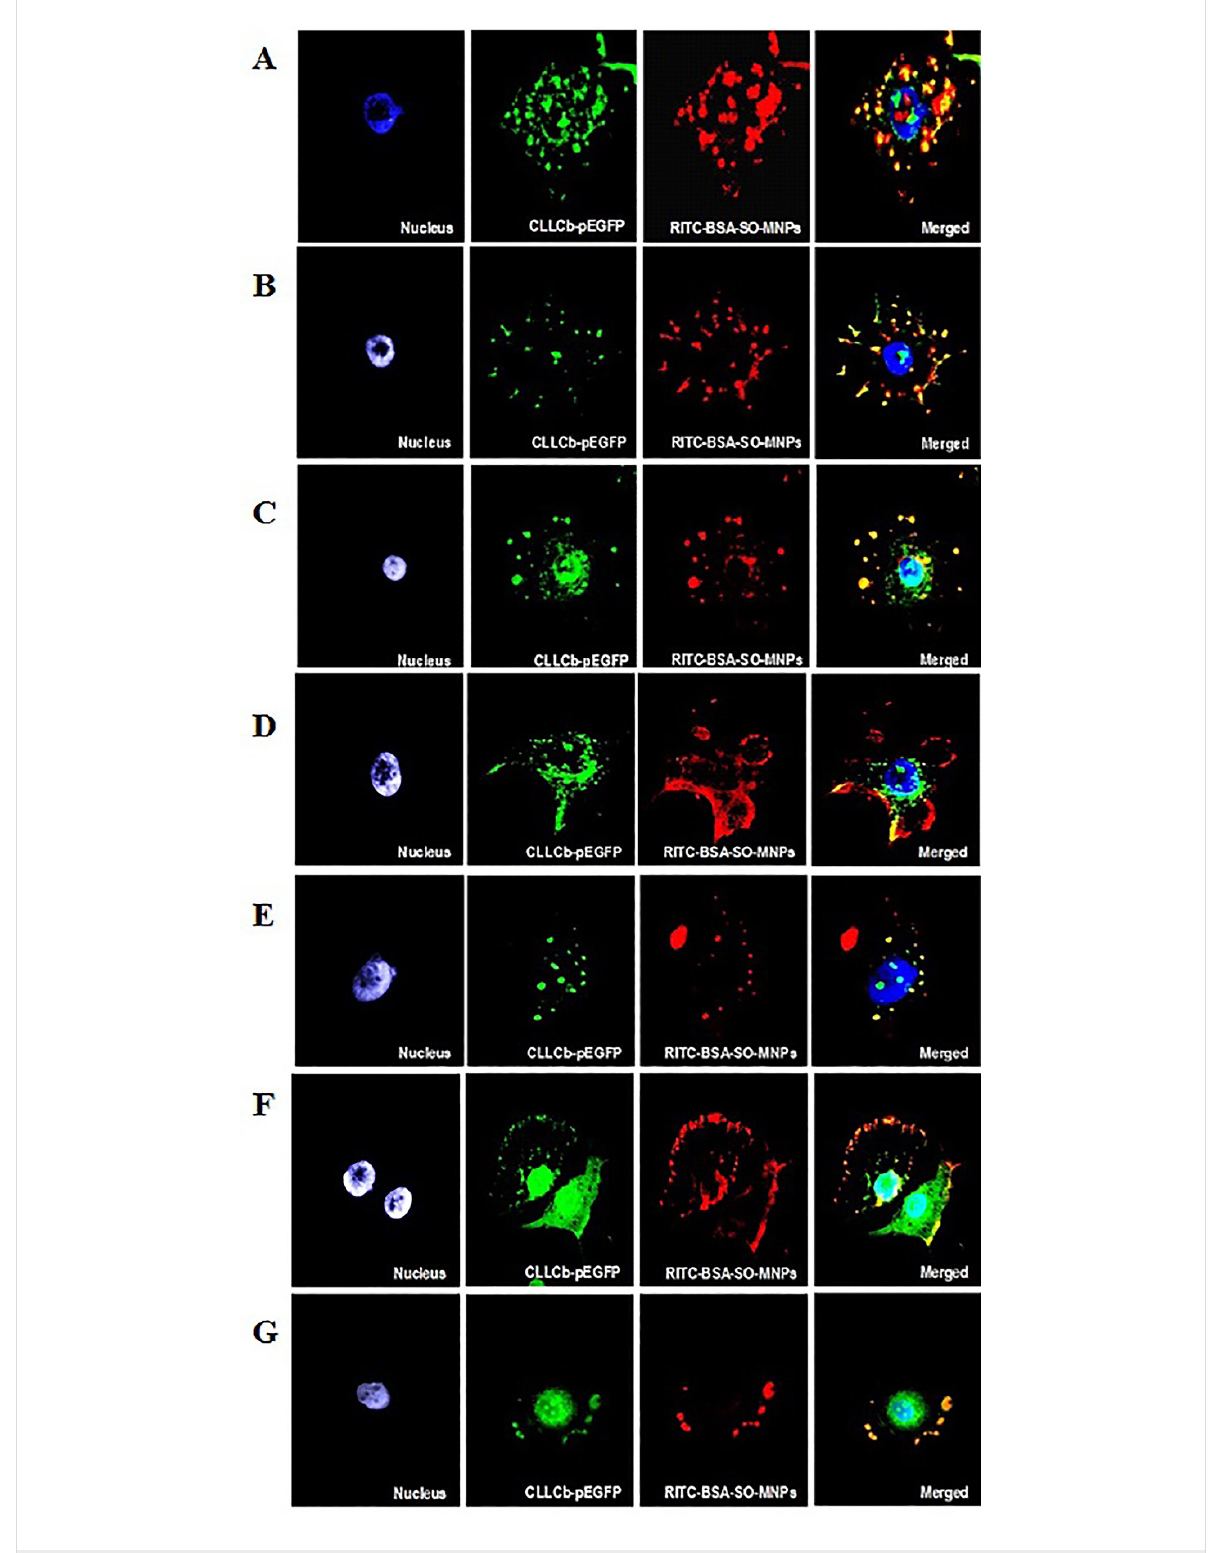
Figure 3: The effect of endocytic inhibitors or cytoskeleton dynamics inhibitors on RITC-BSA-SO-MNPs internalization. A – control, B – chlorpro- mazine, C – monodansylcadaverine, D – dynasore, E – methyl- β -cyclodextrin, F – filipin, G – nystatin. Blue – nucleus (DAPI), green – clathrin, red – RITC-BSA-SO-MNPs, merged; magnification